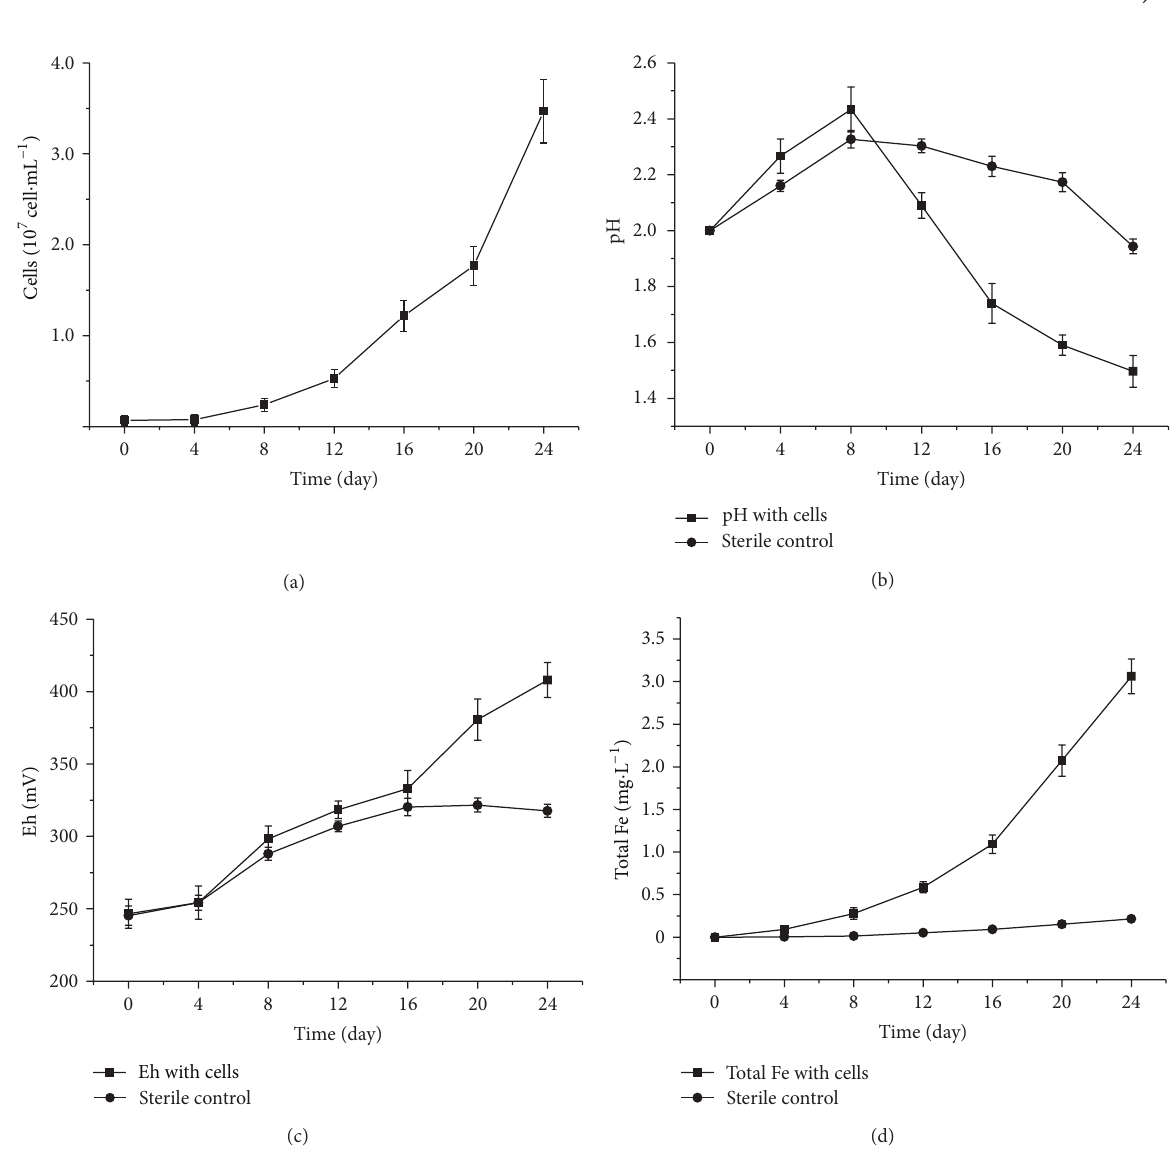
Figure 2: Leaching characteristics of coal’s pyrite with A. ferrooxidans cells and sterile control ( ◼ : cells, e : sterile